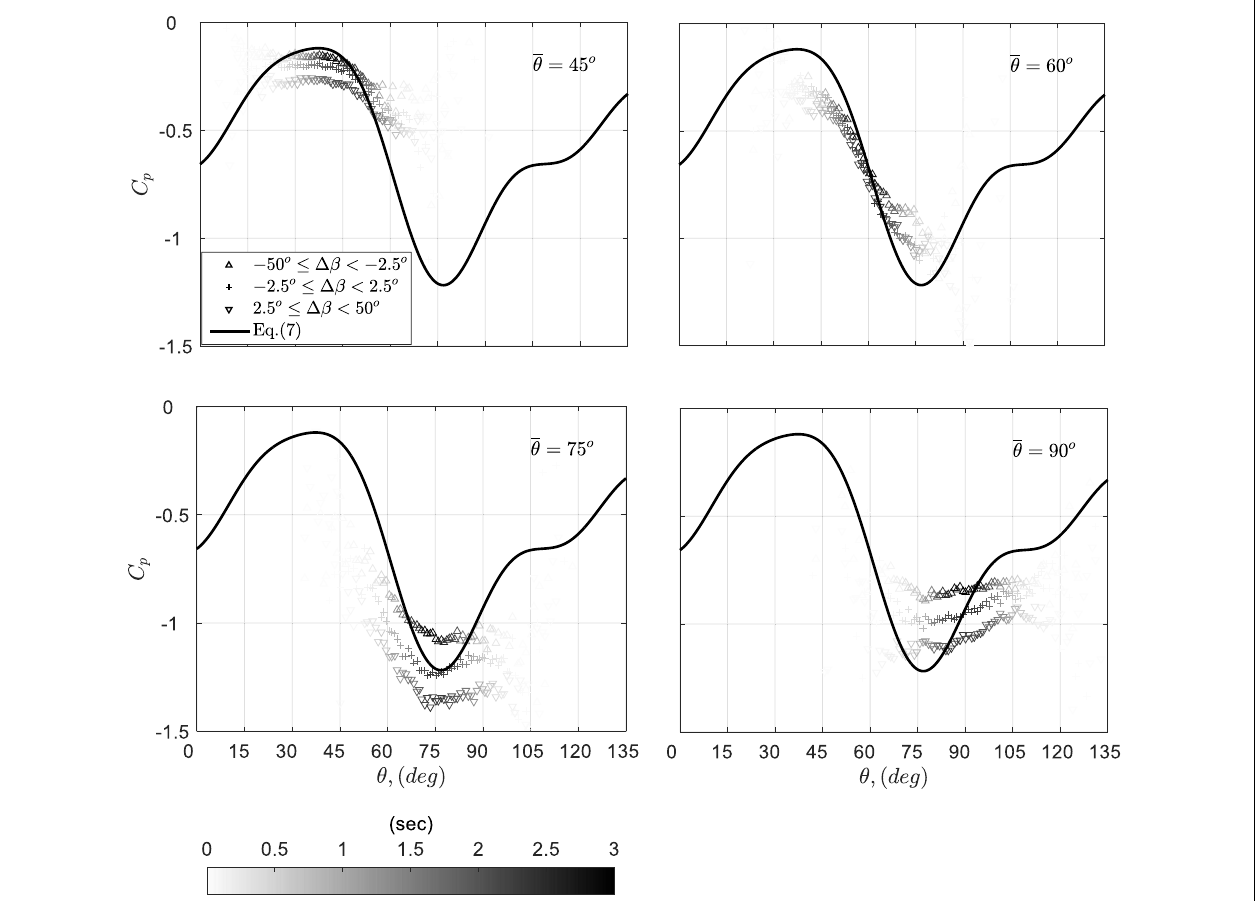
FIGURE 3 | E [ C p,inst | θθθ , βββ ] and C p ( θθθ ) (represented by Eq. 7) for case C-1, mean wind azimuths (cid:22) θ (cid:22) θ (cid:22) θ = 45°, 60°, 75°, and 90°.